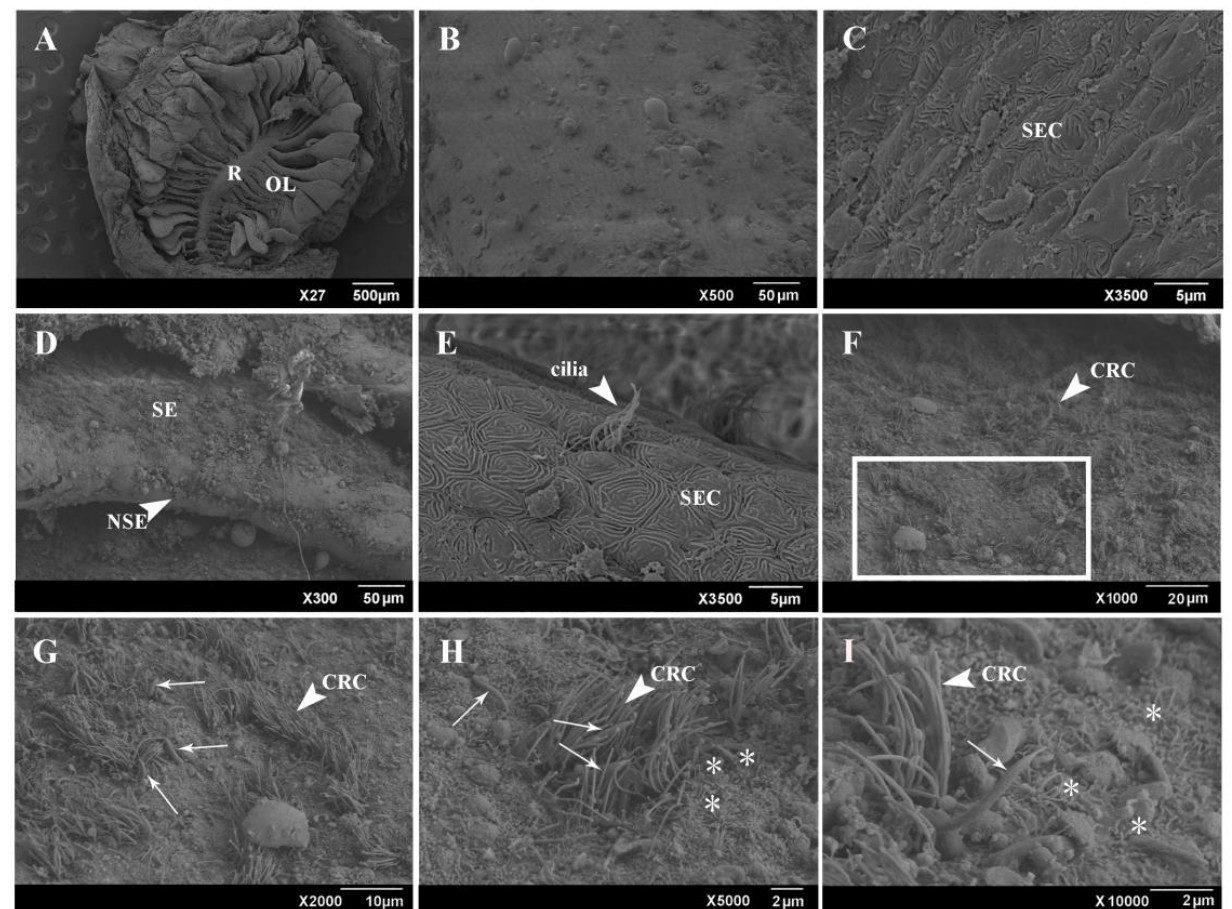
Figure 2. SEM of the general overview of OE. ( A ) General view showing OE that consisted of olfactory lamellae (OL) and olfactory raphe (R). ( B ) Higher magnifications of OE from A showing olfactory raphe. ( C ) Epithelium of olfactory raphe was consisted of stratified epithelial cells (SECs). ( D ) Sensory epithelium (SE) was distributed on the side of olfactory lamellae, and non-sensory epithelium (NSE, white arrow) was distributed on the margin of olfactory lamellae. ( E ) Epithelium of non-sensory epithelium (NSE) of olfactory lamellae consisted of stratified epithelial cells (SECs) and ciliated cells (white arrow). ( F ) Sensory epithelium (SE) of olfactory lamellae was covered with a large number of cilia. ( G – I ) Higher magnification of boxed area in F, showing ciliated receptor cells (short arrow), rod-shaped cilia (long arrow), and microvillous receptor cells (*).